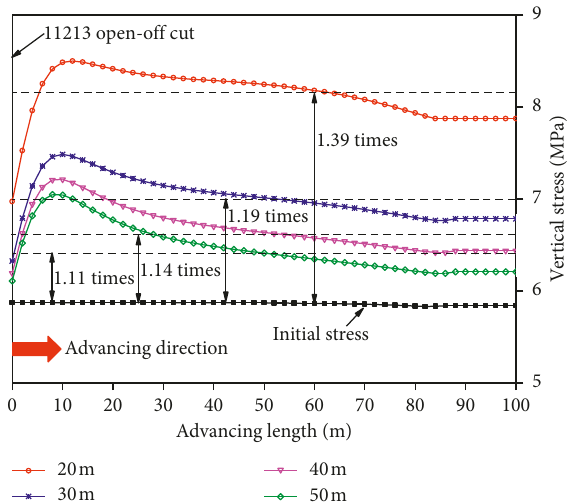
Figure 16: Variation of roof stress at different widths of the chain pillar.